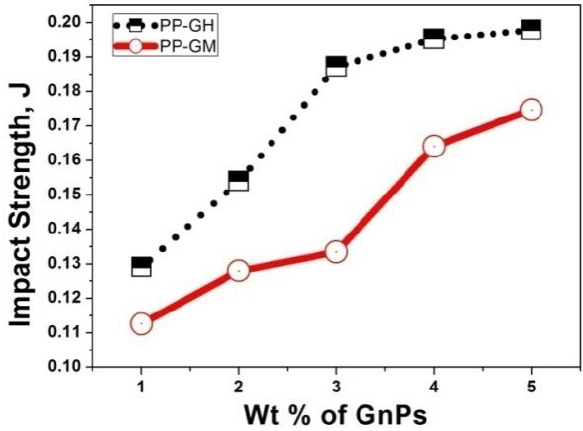
Figure 6. Variation of impact strength with GNP loading.